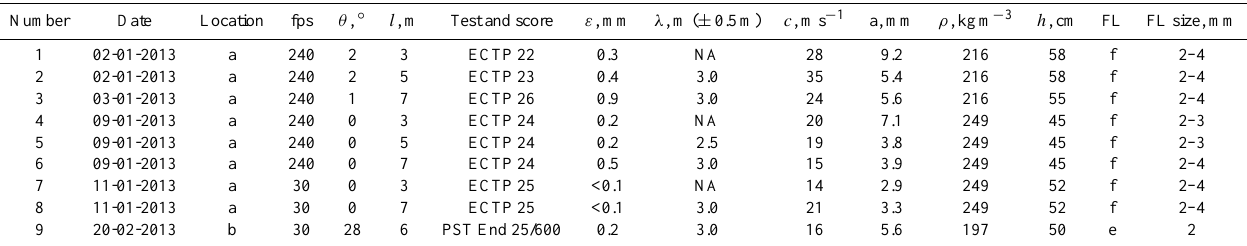
Table 2. Selected tests with full propagation. For an explanation of why these tests were selected see Section 3.2. Location a – Rock Creek Canyon, CA; b – Yellow Mountain, MT; fps – frames per second; θ – slope angle; test beam length l ; Test and score – see Greene et al. (Chapter 2, 2010); ε – displacement uncertainty; λ – wavelength; c – mean wave speed; a – mean collapse amplitude; ρ – mean slab density; h – mean slab height; FL – failure layer crystal type and size (Fierz et al.,